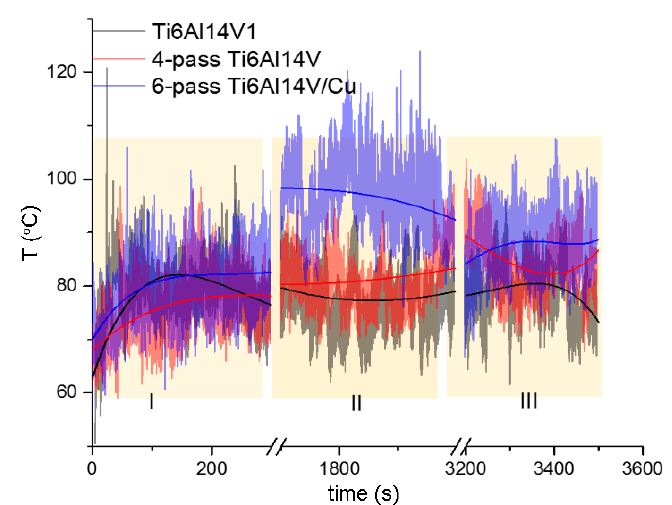
Figure 17. The worn surface temperatures during the 0–300 s (I), 1700–2000 s (II), and 3200–3500 s (III) time intervals. The black, red, and blue curves were obtained by applying polynomial fitting procedures to the corresponding dependencies.